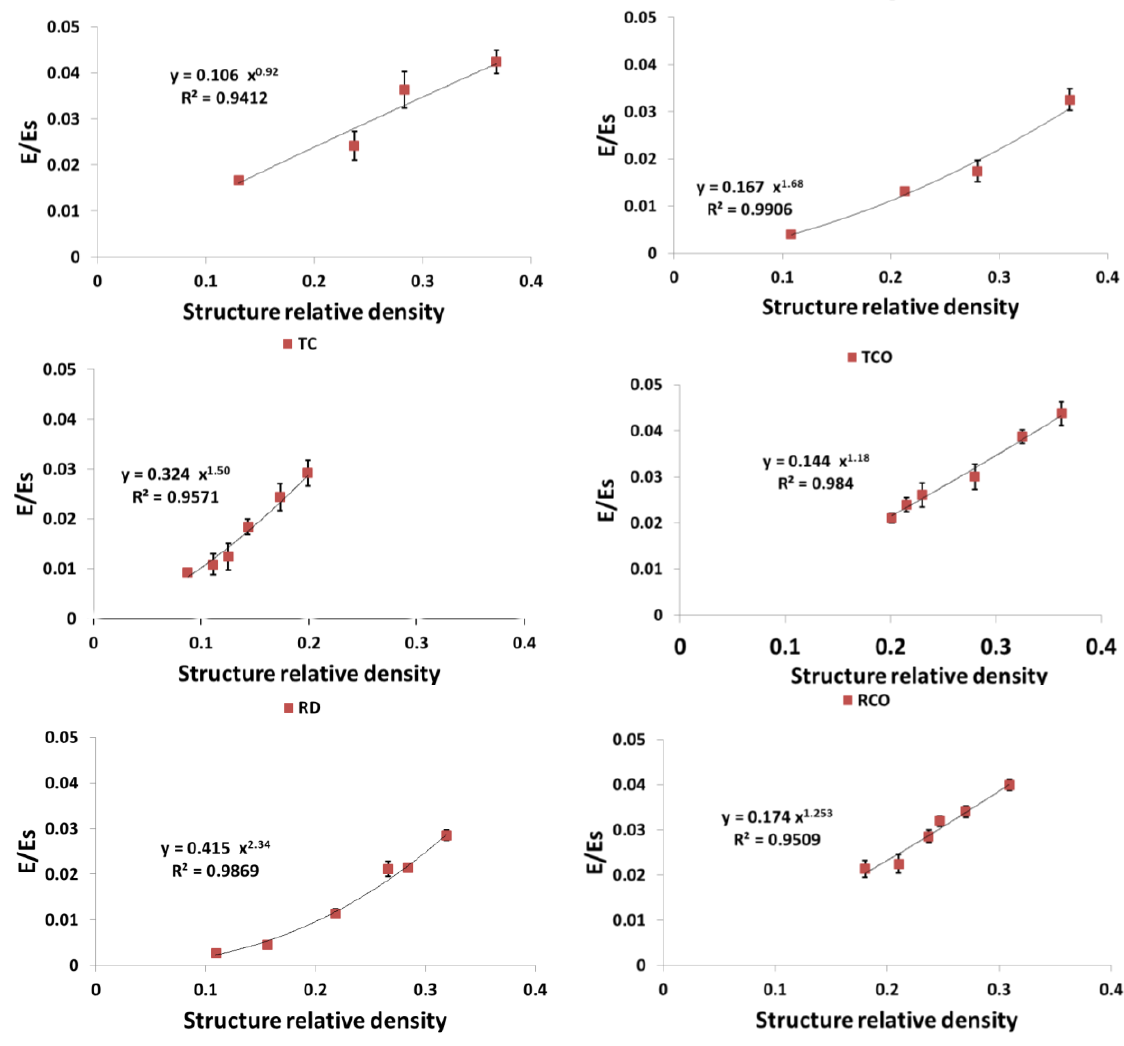
Figure 9. Summary of the elastic gradient results for porous structures basedon different types of unit cell configurations (cubic (C); diamond (D); truncatedcube (TC); truncated cuboctahedron (TCO); rhombic dodecahedron (RD); rhombicuboctahedron (RCO)) and different structure relative densities (see Table 2) (E s indicates the elastic gradient of the structure if it was